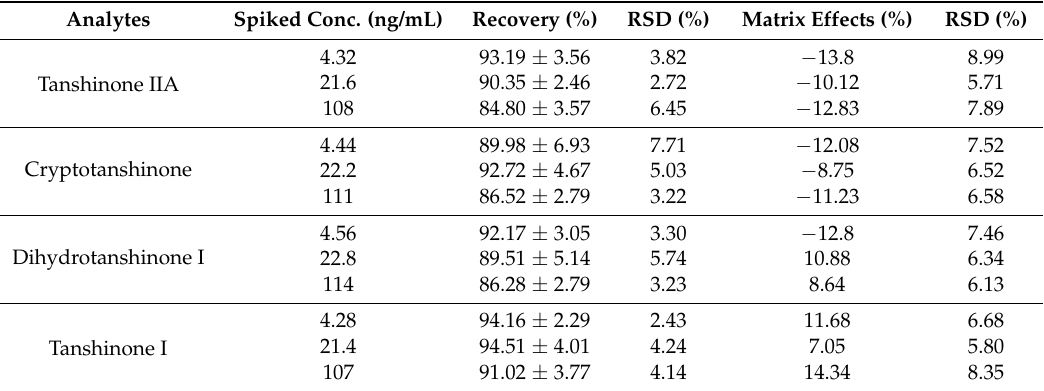
Table 4. Extraction recovery and matrix effects of four tanshinones in QC samples at three concentration levels ( n = 6).